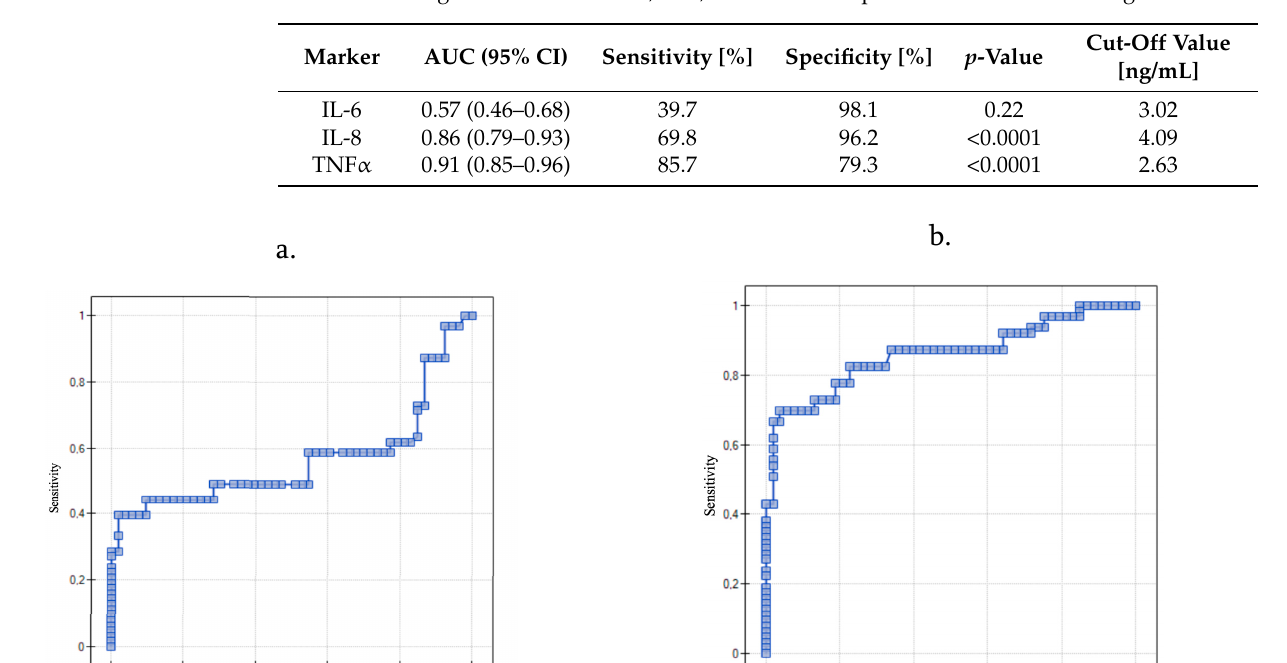
Table 6. The diagnostic values of IL-6, IL-8, and TNF- α for patients with ovarian malignancies.